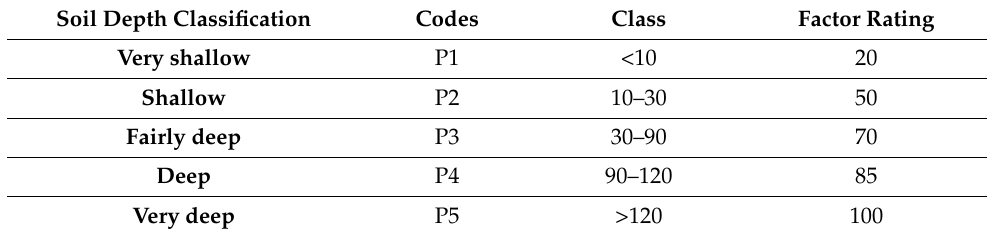
Table 2. Factor ratings of soil depth (cm).